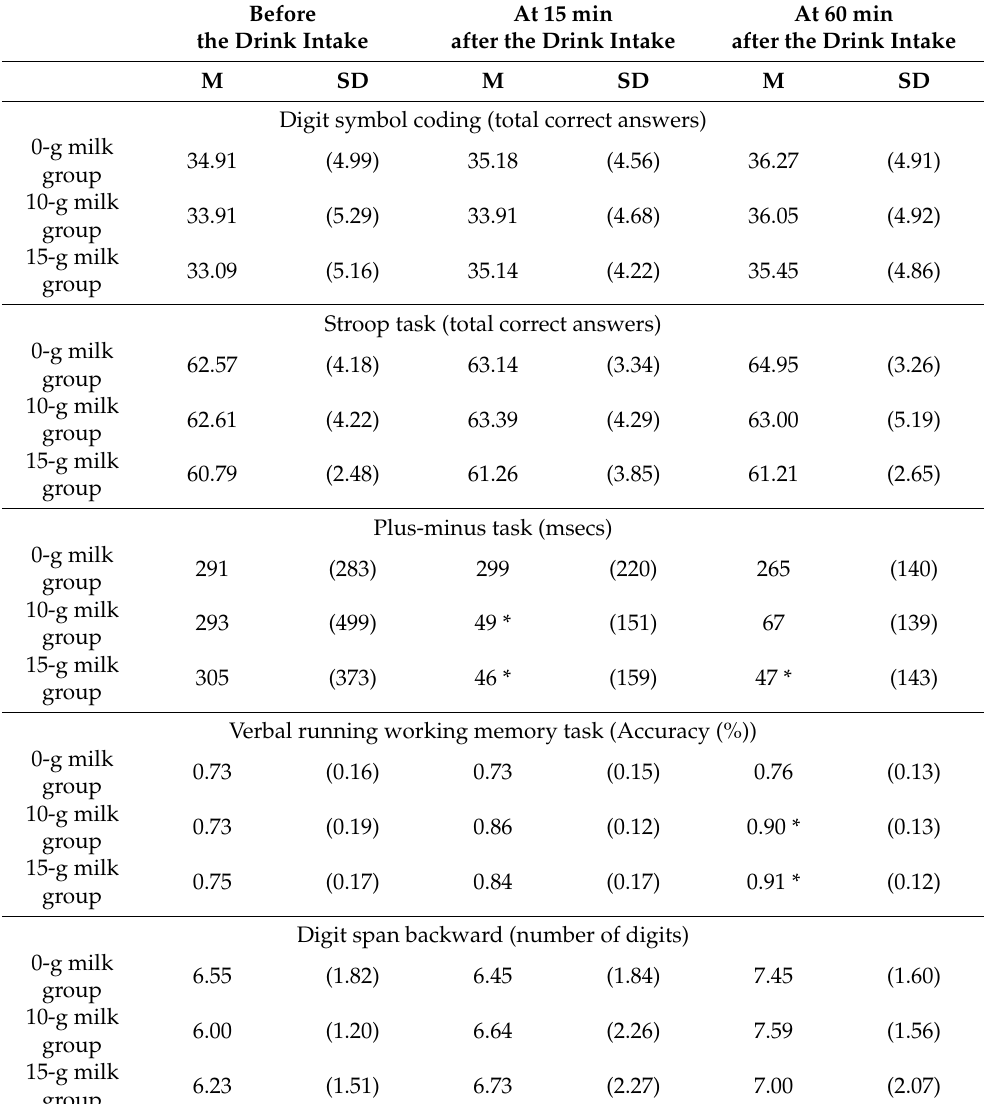
Table 6. Cognitive function before and 15 and 60 min after drink intake.